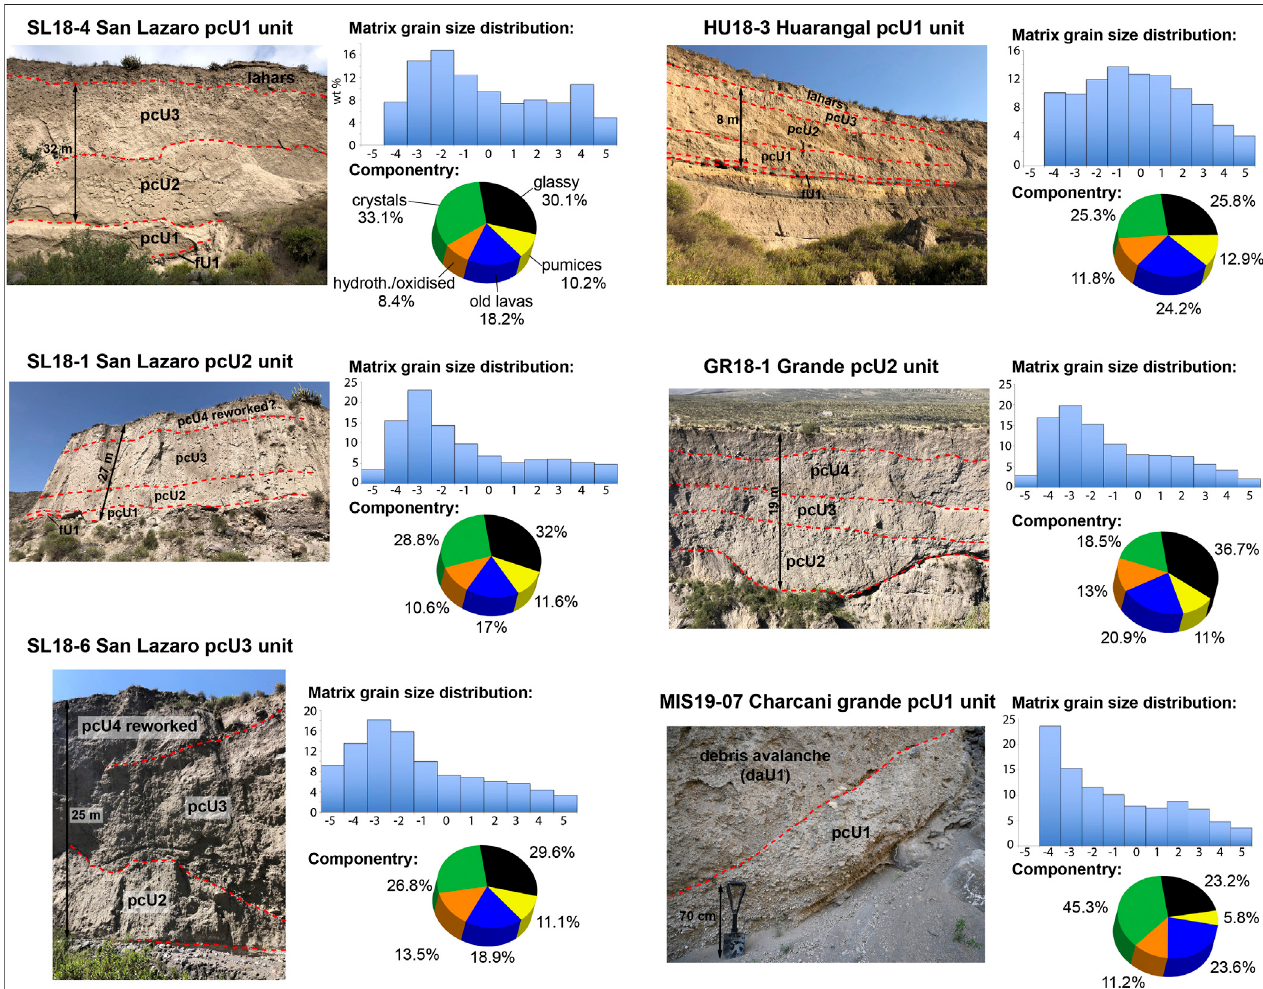
FIGURE 6 | Representative stratigraphic sections and sampling sites selected for grain size analyses and componentry. See Figure 4 for the section location and sampling sites and Table 2 for lithological component description. Dashed red lines indicate depositional unit boundaries or contacts between different facies.